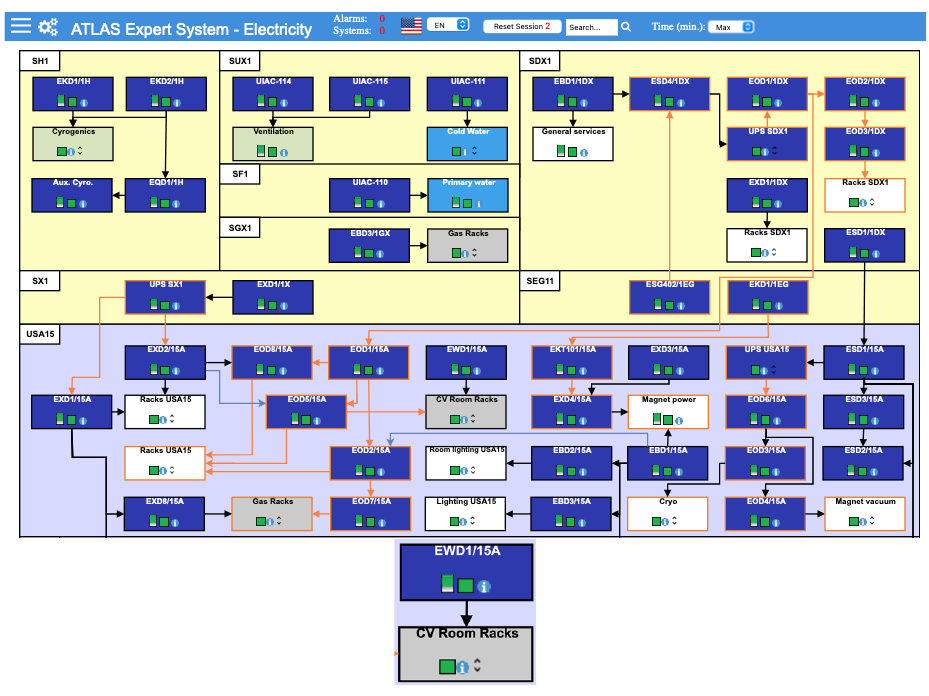
Figure 2. Top: Expert System simulation interface, partial view of electrical distribution. Bottom: example of a switchboard (upper box) and of a group of racks (lower